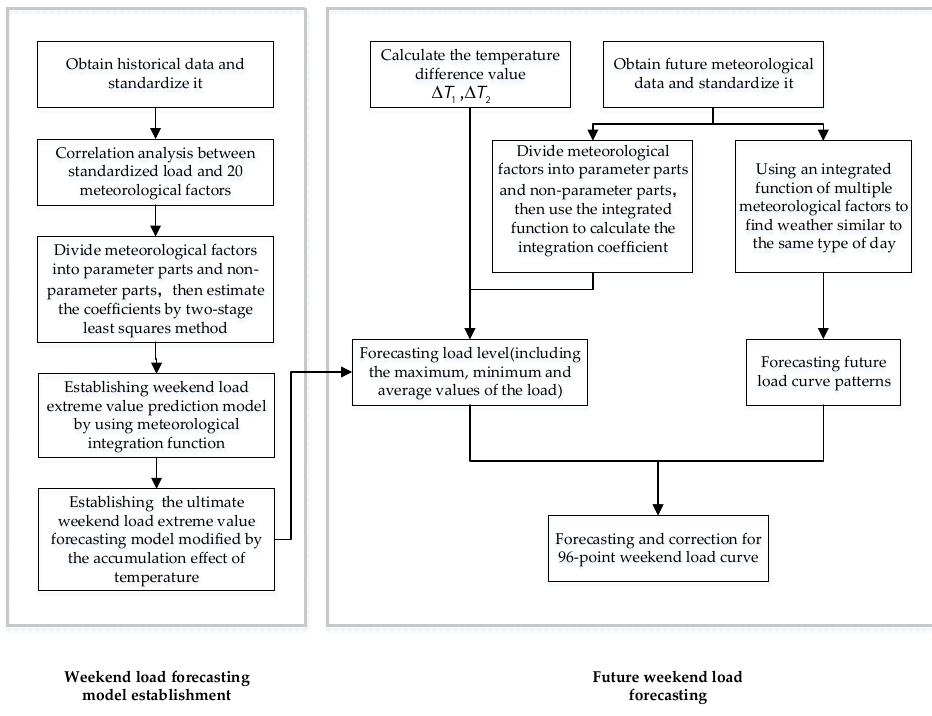
Figure 2. The flowchart of weekend